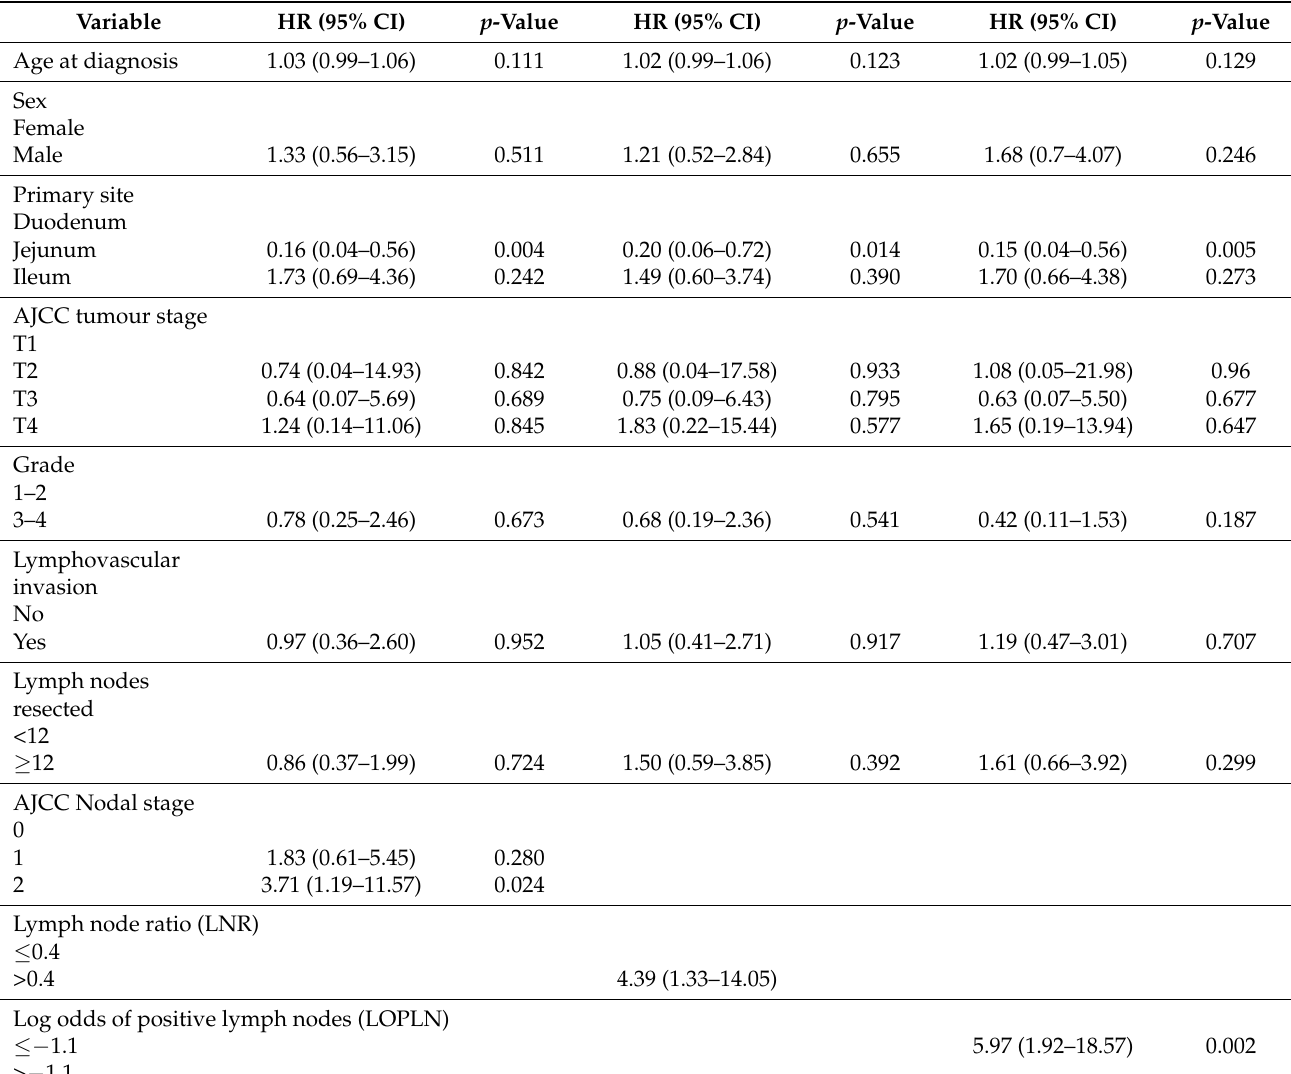
Table 3. Factors associated with overall survival in all patients (n =